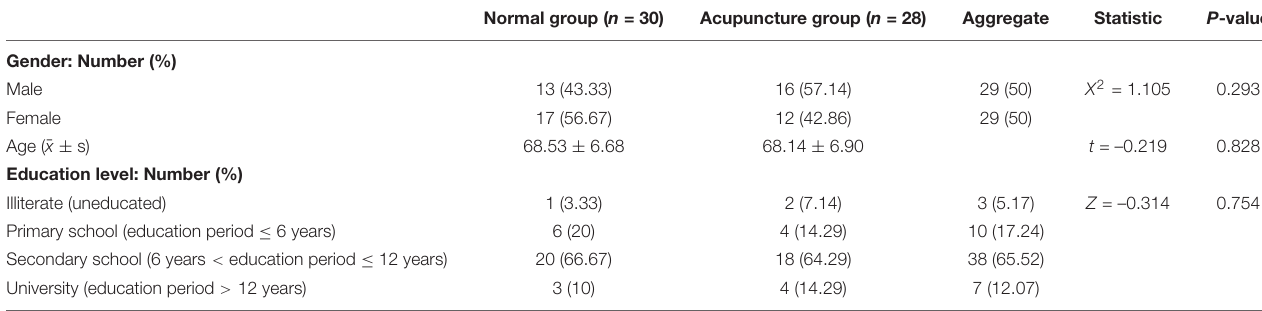
TABLE 1 | Comparison of general conditions of the two